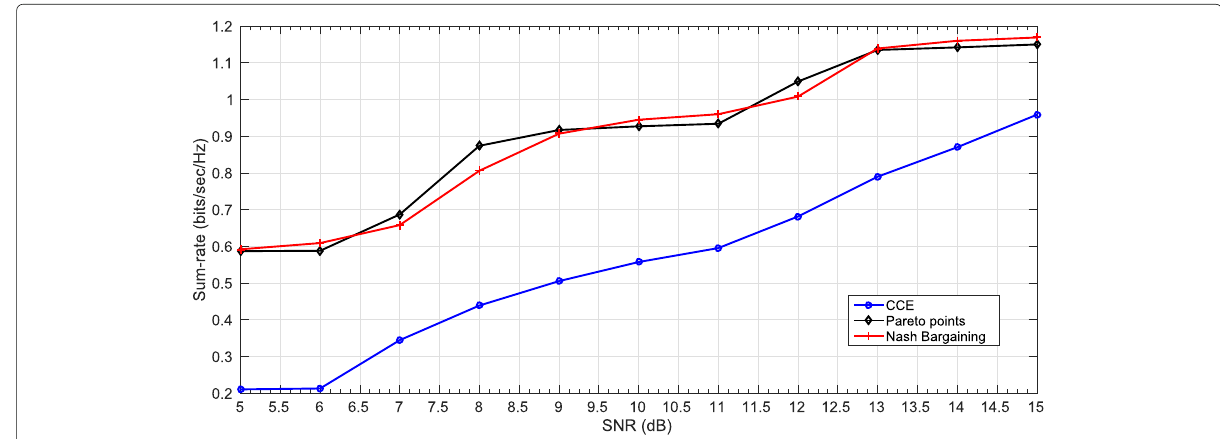
Fig. 1 Sum-rate comparison: CCE vs NBS vs PP (F-MAC, fixed rate